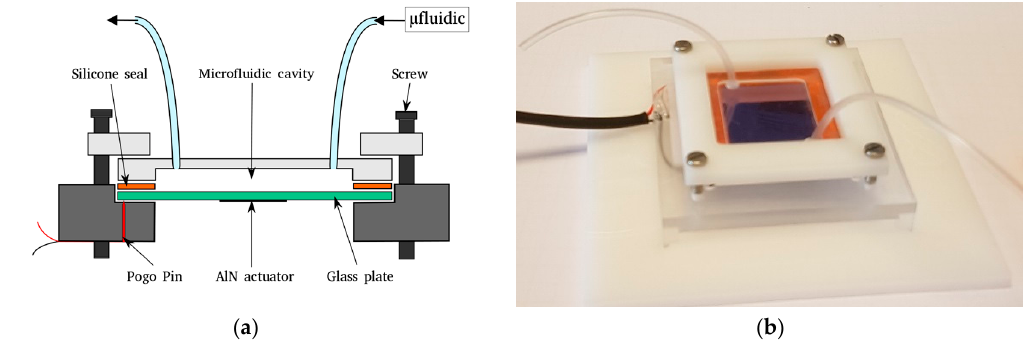
Figure 2. ( a ) Schematic drawing of the microfluidic packaging; ( b ) Photography of the microfluidic